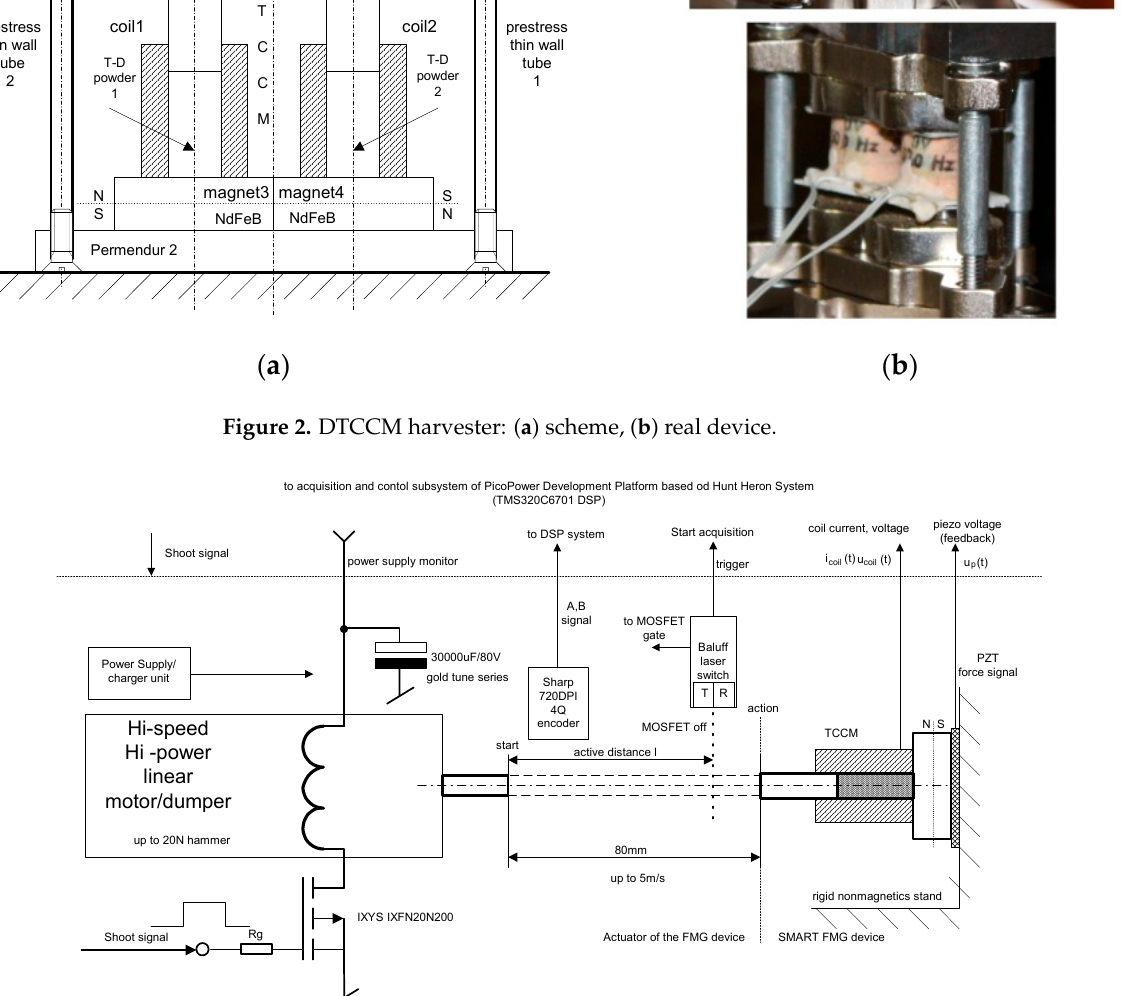
Figure 3. Test stand for TCCM harvester investigations.